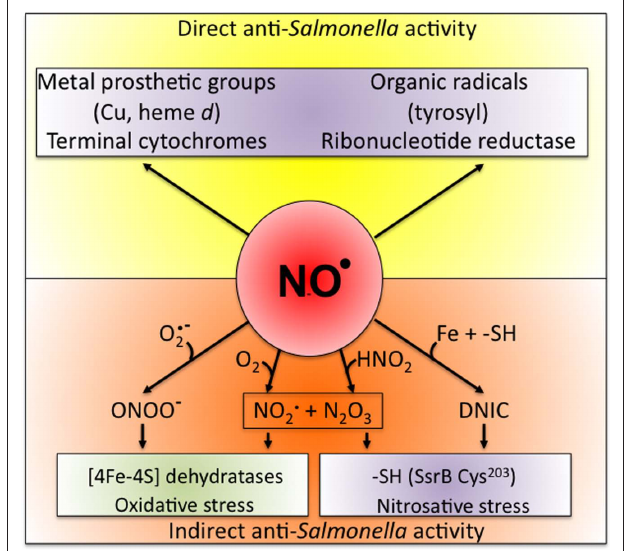
Figure 1 | Biological chemistry of NO and Salmonella targets. NO can react directly (yellow box) with metal prosthetic groups or other radicals. Binuclear centers containing copper (Cu) or iron heme d in terminal quinol cytochrome oxidases of the electron transport chain are directly nitrosylated by NO. The covalent attachment of NO to molecular targets causes nitrosative stress (purple boxes). Investigations in E. coli and mitochondria have shown that a tyrosyl radical in the active site of ribonucleotide reductase can be modified directly by NO. NO can also exert biological functions indirectly (orange box) by forming RNS through its interactions with superoxide anion (O 2 − ), molecular oxygen (O ), or iron and low-molecular weight thiols (-SH). 2 Nitrogen dioxide (NO ) and dinitrogen trioxide (N O ) can independently arise 2 2 3 from the condensation of acidified nitrite (HNO ) or the auto-oxidation of NO in 2 the presence of O . Peroxynitrite (ONOO − ), NO , and N O are strong oxidants. 2 2 2 3 [4Fe–4S] clusters of dehydratases are frequent targets of ONOO − (green box). N O and dinitrosyl–iron complexes (DNIC), which frequently target 2 3 thiol-containing proteins, are common sources of nitrosative stress. The redox active thiol of Cys 203 in the dimerization domain of the SsrB response regulator that controls SPI2 gene transcription is a bona fide sensor of nitrosative stress in